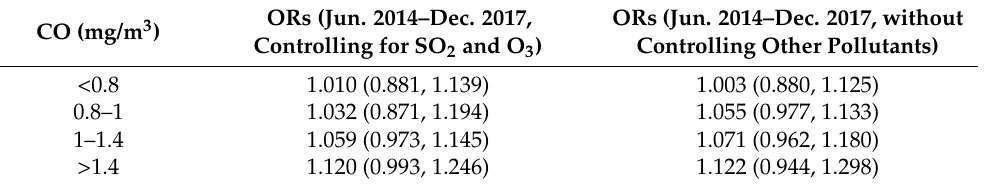
Table 4. Influence of CO on gynecological cancers in Phase 4 with/without control of other air pollutants.